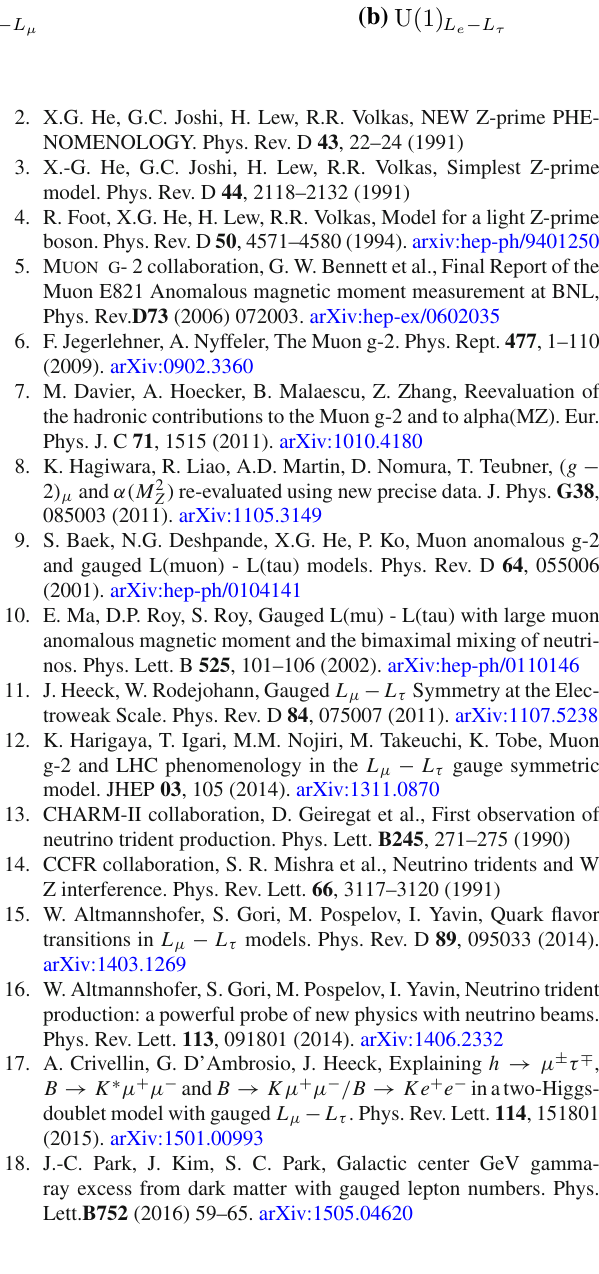
Fig. 8 The mass ratios m 2 / m 1 and m 3 / m 1 as functions of the Dirac CP phase δ for the gauged uncertainty coming from the 1 σ error in the neutrino mixing parameters. The thin dotted line corresponds to m 2 , 3 / m 1 =